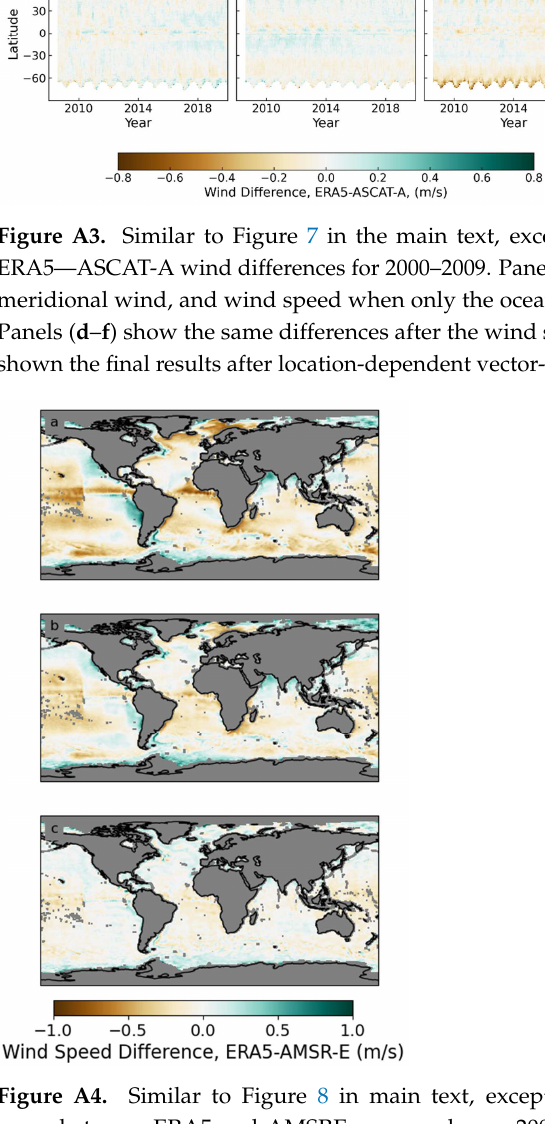
Figure A4. Similar to Figure 8 in main text, except for AMSR-E. Global maps of the differences between ERA5 and AMSRE, averaged over 2003–2010. ( a ) shows the differences relative to ERA5_OSCAR. As was the case for SSM/I F13, there are large regional biases. ( b ) shows the differences relative to ERA5_ADJ. The adjustments applied to ERA5 reduced the ERA5-AMSR-E differences substantially, but some regional differences remain. After wind speed adjustments were applied to the AMSR-E winds, the differences are much reduced ( c ). We note that the corrections applied to AMSR-E we derived using all Rad_LO instruments with global coverage (AMSR-E, AMSR2, and WindSat).